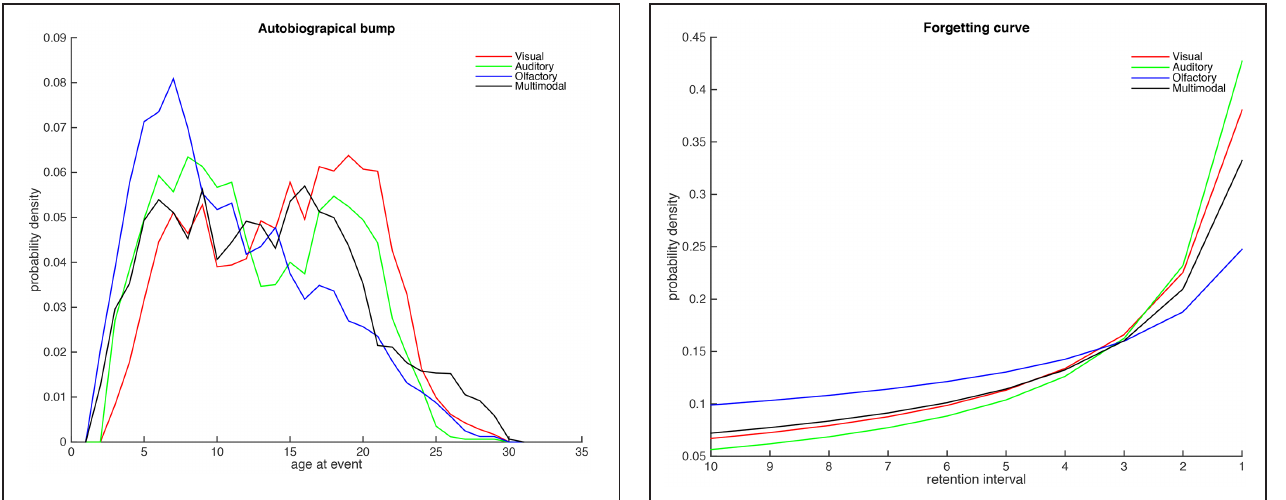
FIGURE 3 | The forgetting curves of the four